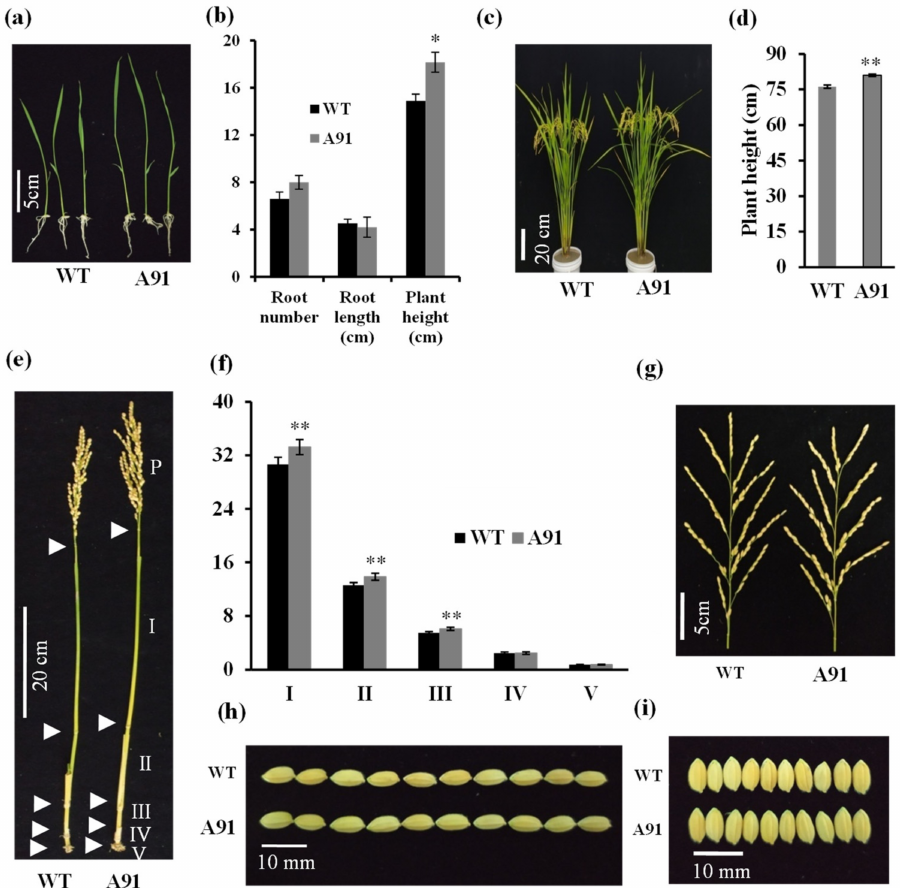
Figure 3. The phenotypic comparison of the A91 and WT. ( a ) The height of seedlings at one-week-old growing in 1 MS media; ( b ) the comparison of the root number, the root length and the shoot length 2 in WT and A91 (n = 9 biological replicates); ( c ) the morphology of plants at the reproductive stage; ( d ) the measurement of plant height (n = 30 biological replicates); ( e ) the phenotype of tiller; ( f ) the measurement of internode length (n = 30 biological replicates); ( g ) the structure of panicle; ( h ) 10 seeds length; ( i ) 10 seeds width, values are expressed as means ± SE; * and ** denote significant t -test results at p < 0.05 and p < 0.01,